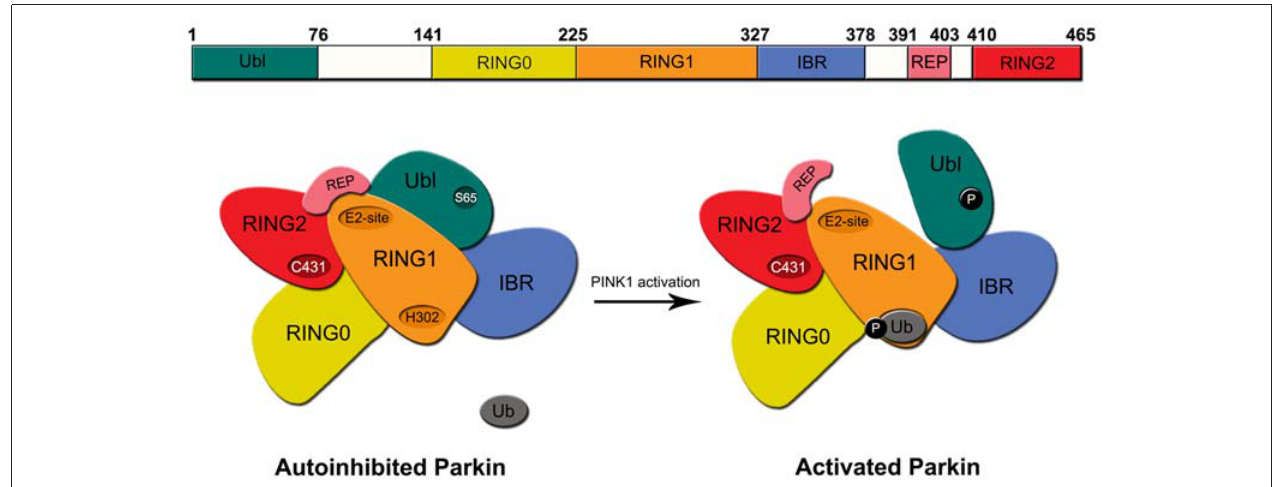
FIGURE 1 | Structure of regulation of Parkin. Top , Schematic depiction of parkin structure. Bottom , A model of Parkin activity regulation—Under normal conditions, Parkin exists in an auto-inhibited state where access to its E2-binding RING1 site is occluded by its Ubl and repressor element of parkin (REP) domains and access to its RING2’s active site is blocked by the RING0 domain. Upon the phosphorylation Parkin’s Ubl domain by PINK1 at Serine 65 (S65) and the concomitant engagement of RING1 with phosphorylated ubiquitin, the Ubl is displaced away from RING1, which led to the structural rearrangement of the various domains of Parkin. The enzyme consequently becomes fully